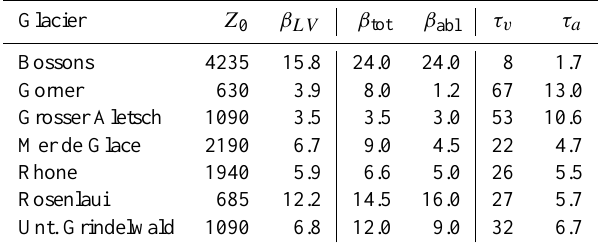
Table 2. LV -model parameters of the best-matching DESM: ver- tical elevation difference of the accumulation area Z 0 , bed slope angles of the LV -model β LV , average slope angles of the whole glacier and the ablation area β tot and β abl , the Harrison volume timescale τ v , and the length response timescale τ a .